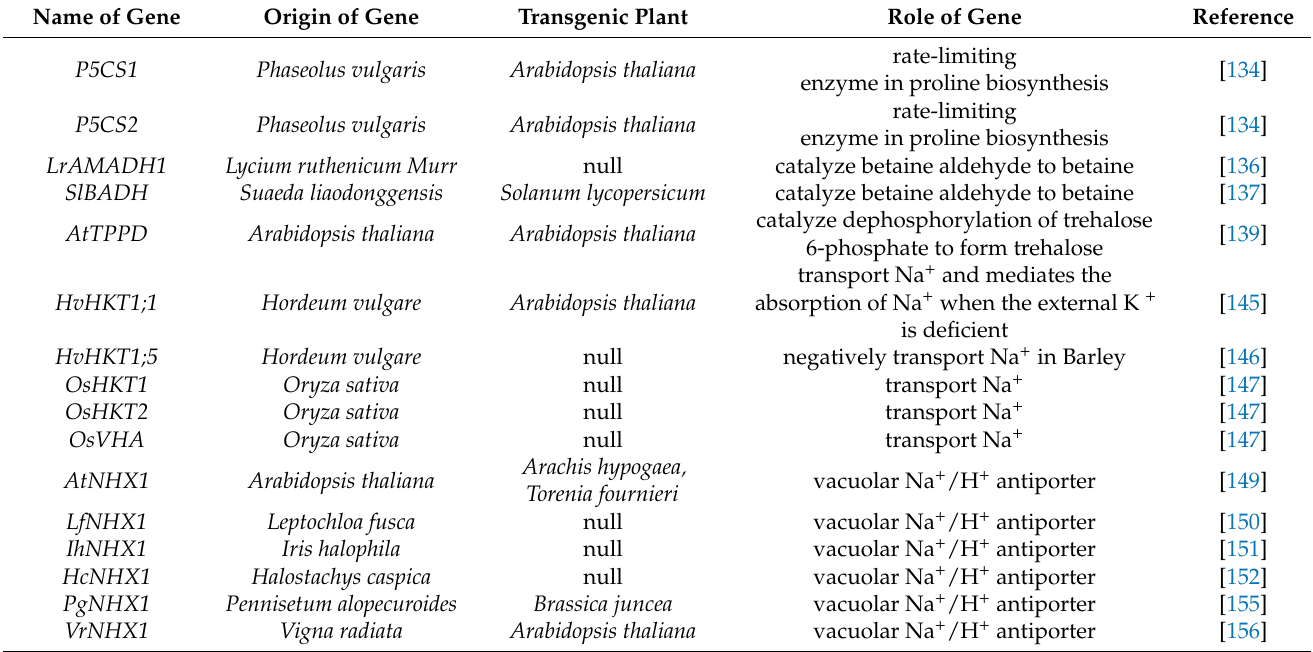
Table 2. Salt stress-related